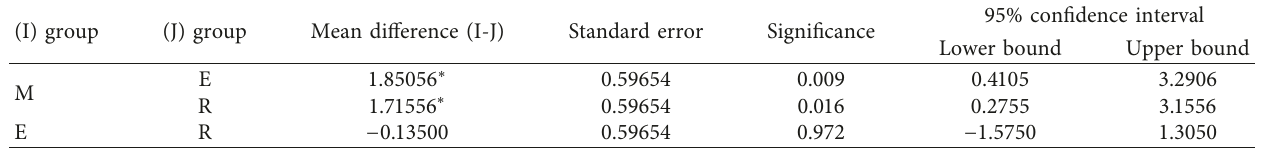
Table 10: Tukey post hoc test for the delayed posttest scores.